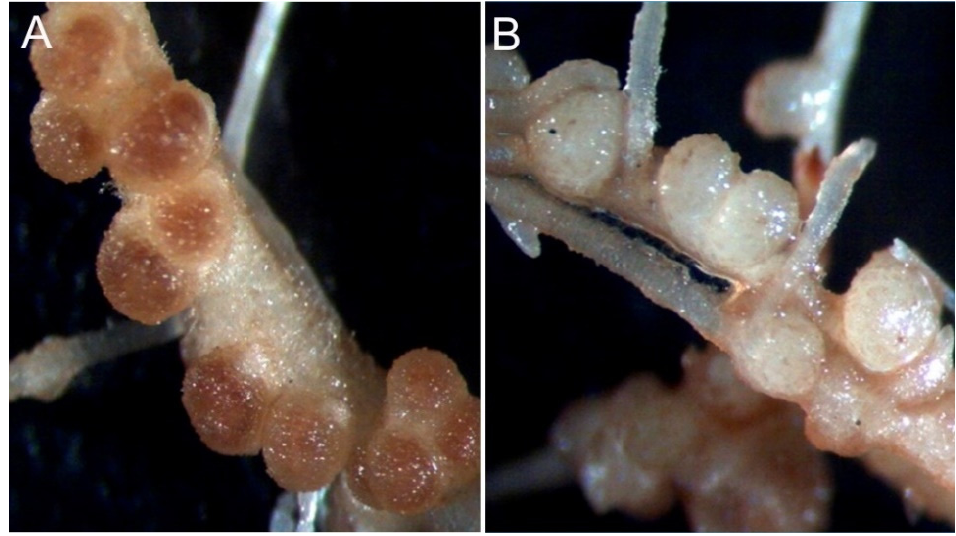
Figure 3. ( A ) Functional nodules produced by strain RZC12. ( B ) Non-functional nodules produced by the RZC1 strain.